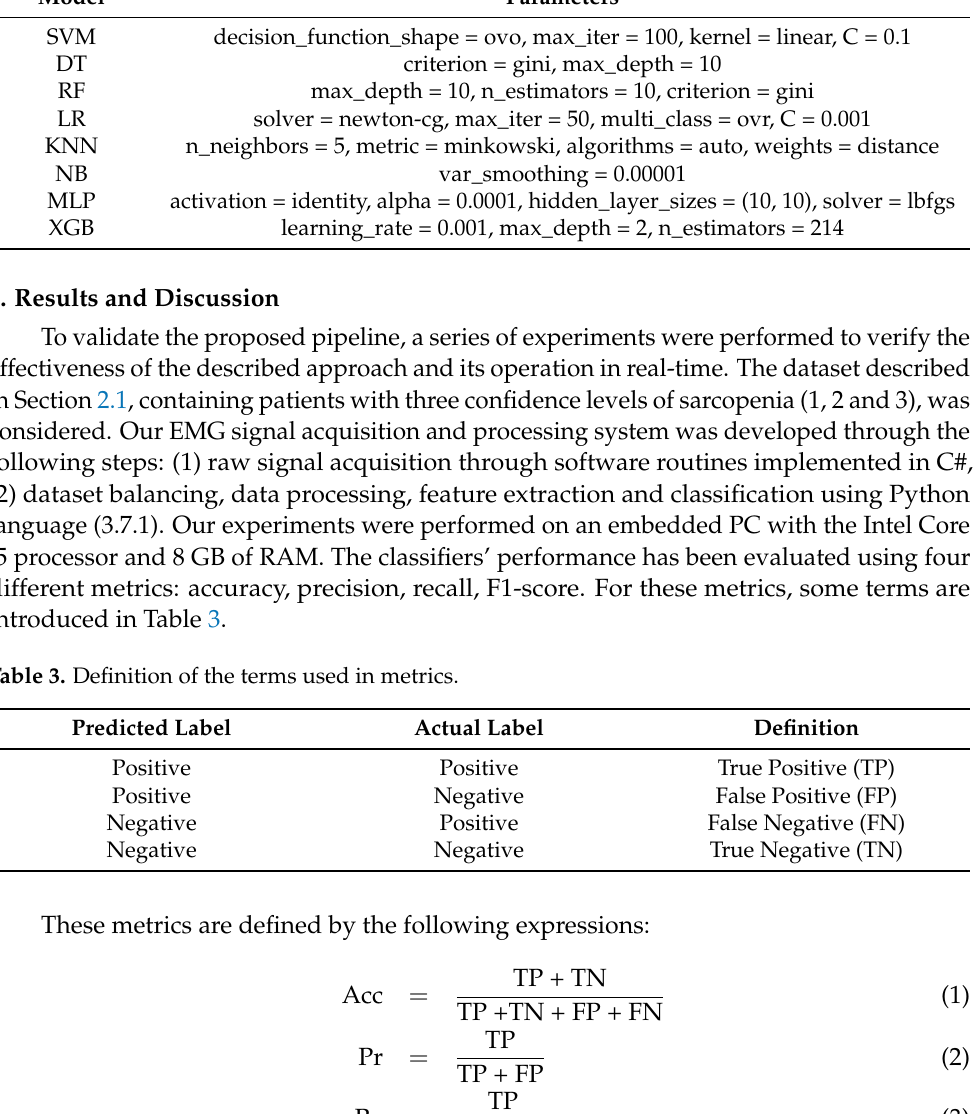
Table 2. Parameters used for classification models. Model